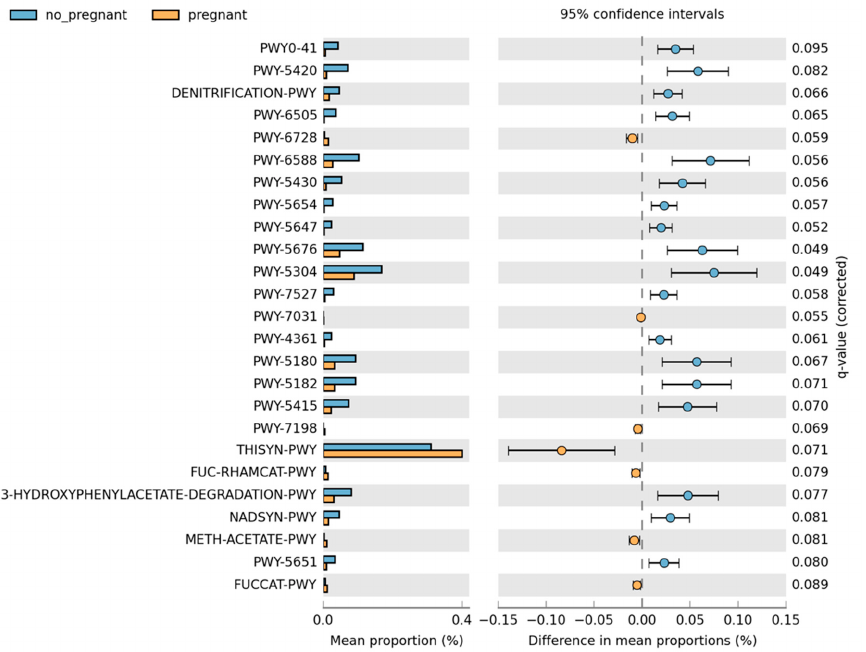
Figure 3. Differences in the pathway relative abundance between pregnant and non-pregnant women. The difference was estimated using Welch’s t -test (adjusted for Benjamini–Hochberg FDR < 0.10).